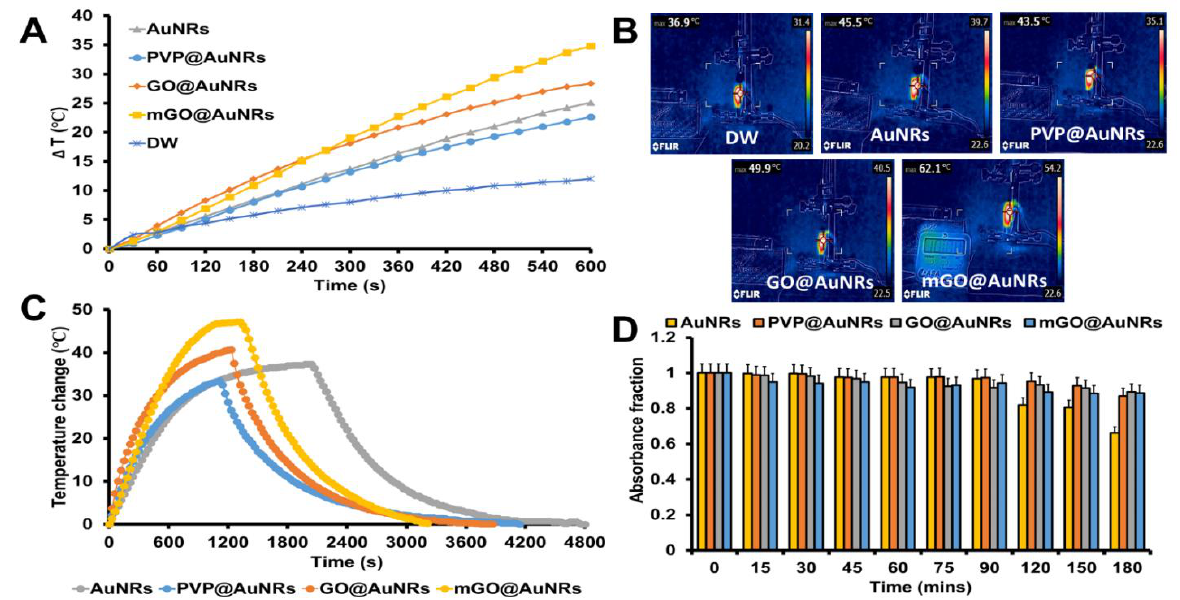
Figure 5. ( A ) Photothermal response of water, AuNRs, PVP@AuNRs, GO@AuNRs, and mGO@AuNRs after irradiation with laser at 1.27 W.cm −2 for 10 min. ( B ) Thermal IR images of water, for 10 min. ( C ) Temperature profile generated by AuNRs, PVP @AuNRs, GO@AuNRs, and